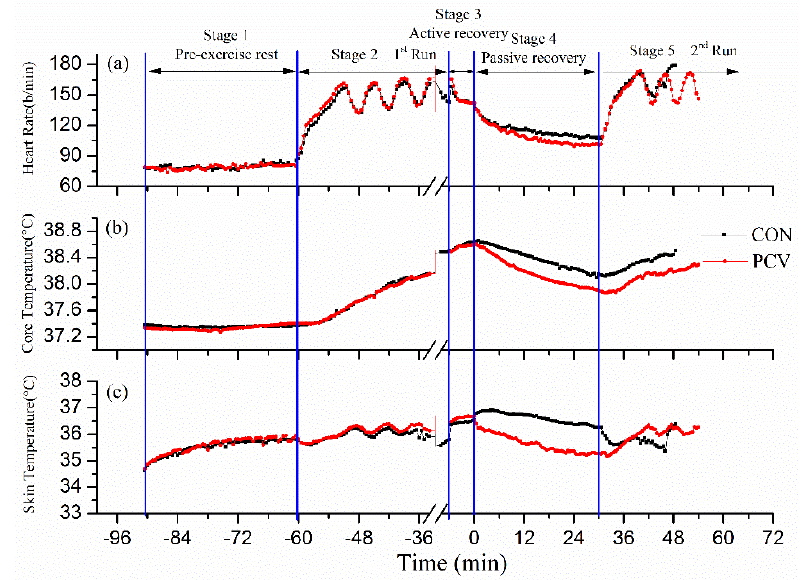
Figure 3. Comparisons of ( a ) heart rate, ( b ) core temperature, and ( c ) skin temperature in control group (CON) with those in PCV.